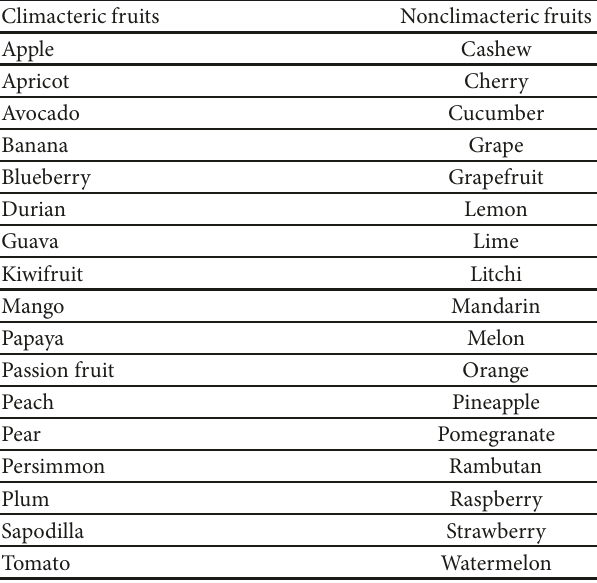
Table 1: Classification of fruits as climacteric and nonclimacteric fruits (source [4,